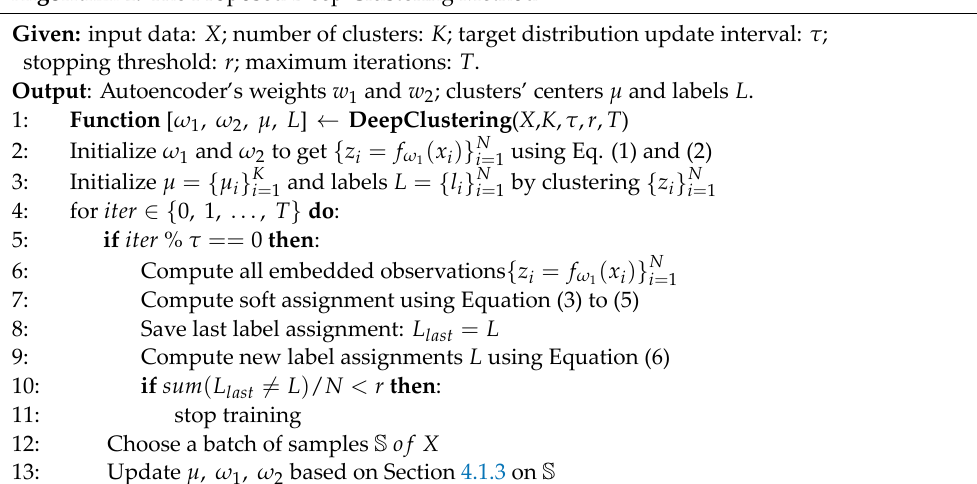
Algorithm 1: The Proposed Deep Clustering